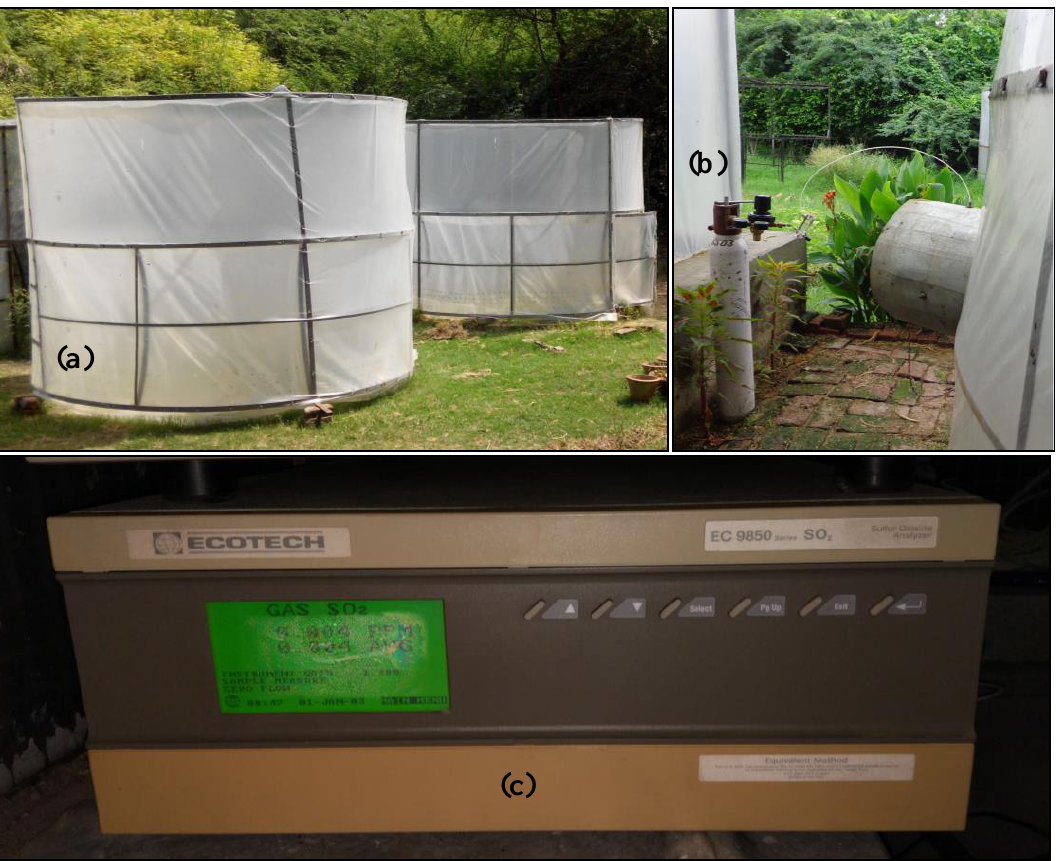
Figure 1. Open-top exposure chambers used to expose plants to SO 2 ( a ); Exposure chamber attached to SO 2 cylinder ( b ); SO 2 gas analyzer ( c ).